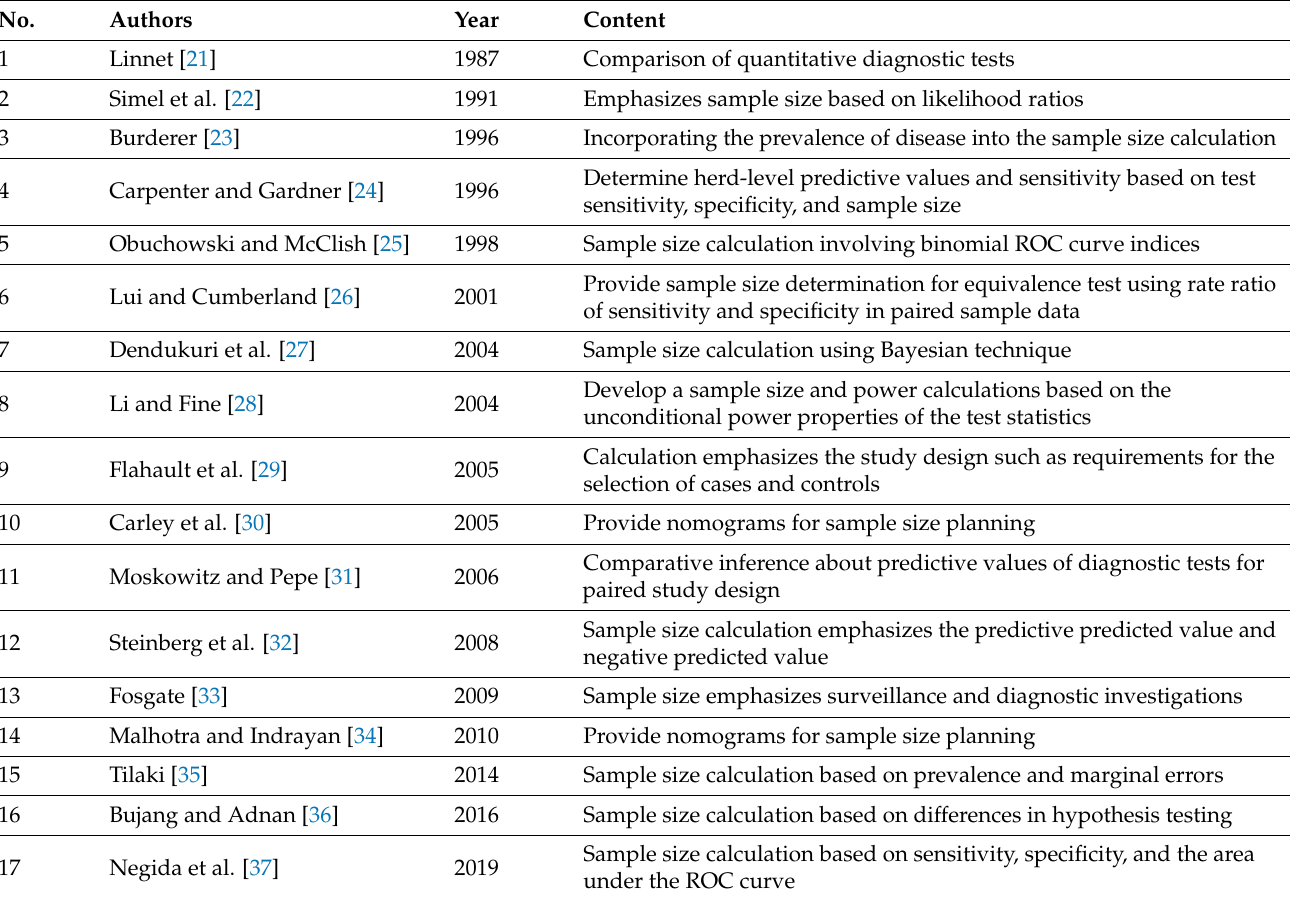
Table 1. Summary of existing published literature related to conducting a proper sample size planning for performing sensitivity and specificity